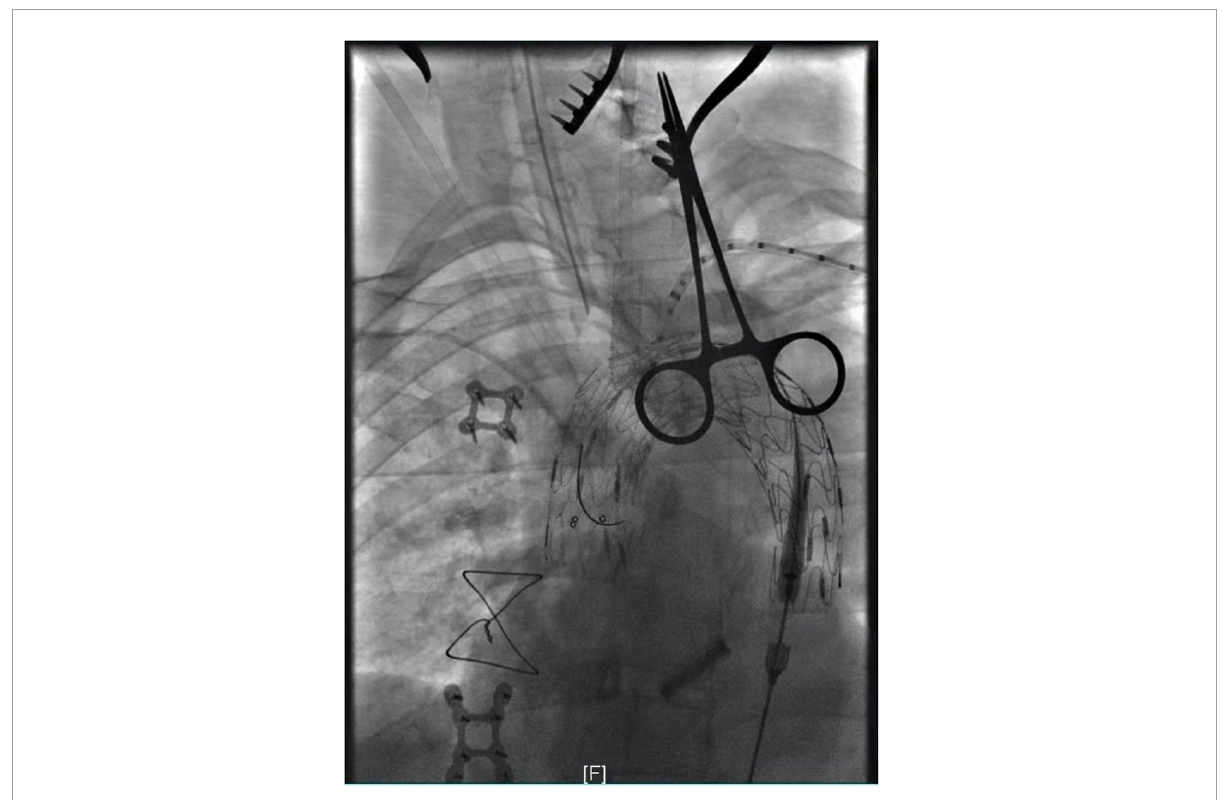
FIGURE2 Intra-operative angiography after in situ fenestration of the LCA, it was the first branch of the aortic arch to undergo in situ fenestration.